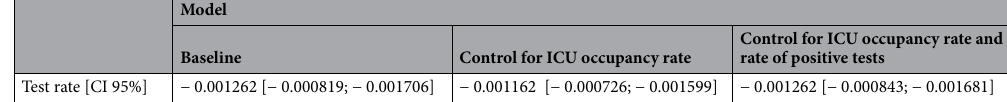
Table 2. Estimation of the effect of SARS-CoV2 testing strategy on the mortality rate using fixed effect model in the all-departments sample, France, March–May 2020. (n = 94). The models analyzed 45 periods, with 12 regions, and 94 departments. Results are calculated in percentage points with 95% confidence intervals (CI 95%). When controlled for ICU occupancy and rate of positive tests, the model using all-departments sample shows an increase of 1 percentage point in the tests/hospitalizations ratio leads to a statistically significant decrease in the case mortality rate of 0.0013 percentage point. CI confidence interval, ICU intensive care unit.